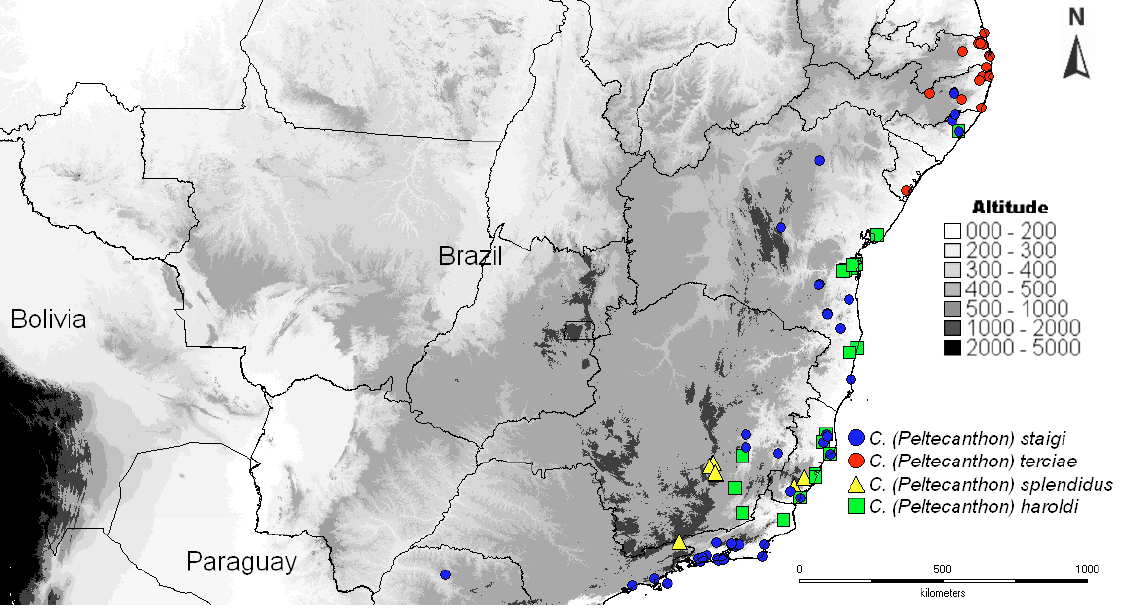
Fig. 10. Distribution map for species of Peltecanthon : C. ( P. ) staigi (Pereira, 1953) (blue circle); C. ( P. ) haroldi Harold, 1867 nom. nov. (green square); C. ( P. ) splendidus Schmidt, 1922 (yellow triangle); C. ( P. ) terciae sp. nov. (red